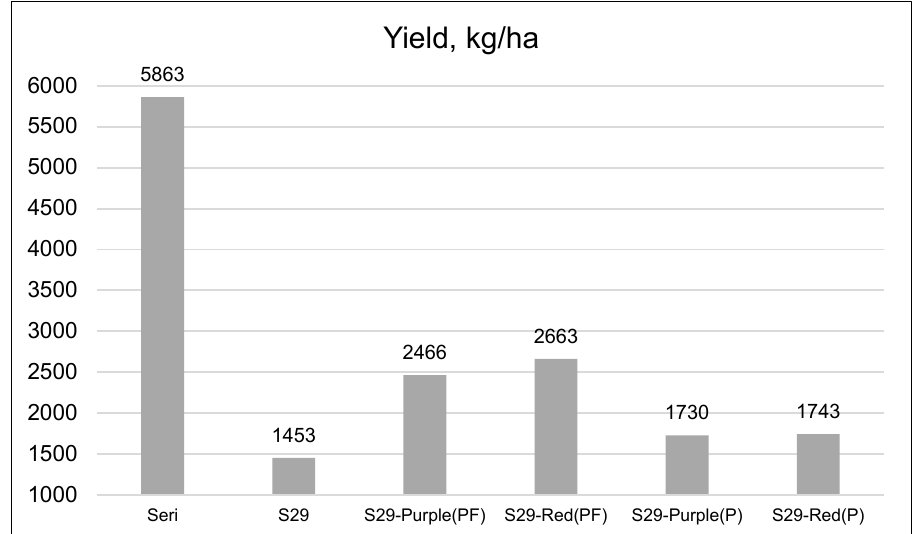
Figure 1. Grain yield of Seri (check), S29 (parent), and isogenic lines in 2018, Konya, Turkey (LSD 0.05 = 1142 kg/ha).